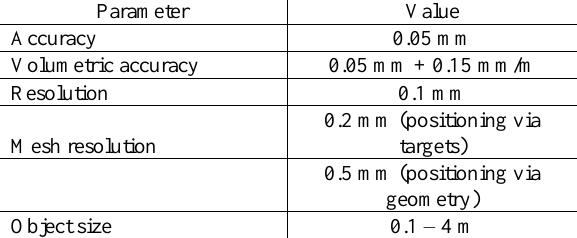
Table 3. Specifications for hand-held 3D scanning system Creaform GO!Scan.